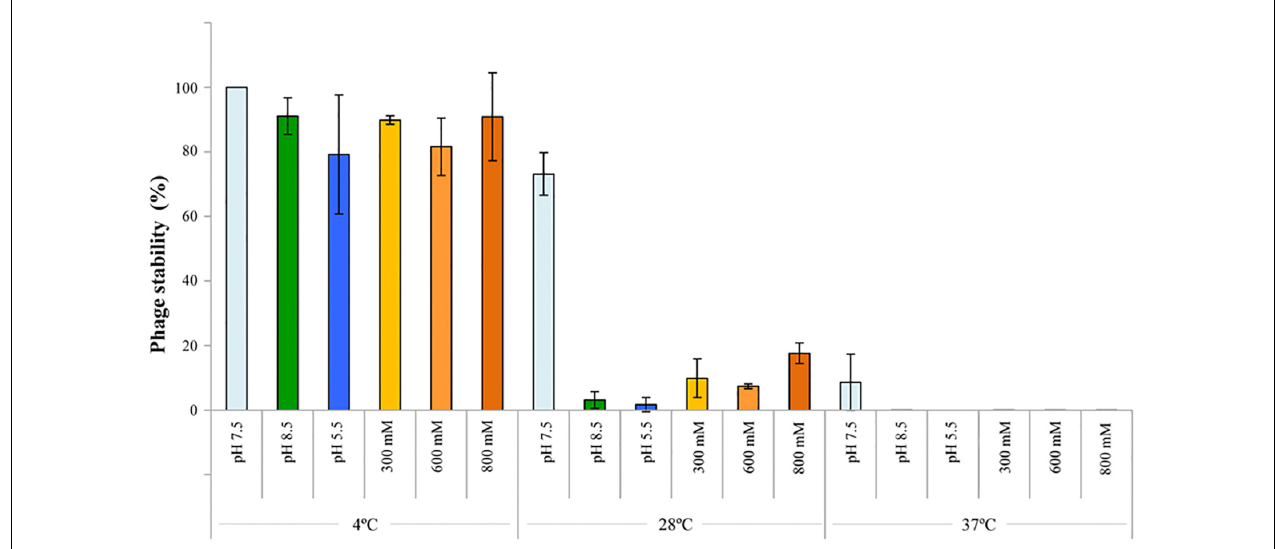
FIGURE 3 | Thermal/pH/salinity sensitivities of P_ort11. To study the sensitivity, the phage was incubated at those conditions for 1 week. The titer of phages pre- and post-exposure was determined. Optimal conditions (4 ◦ C, pH 7.5, ClNa 100 mM) acted as control. The values indicate the means of results from three independent experiments, including standard error.